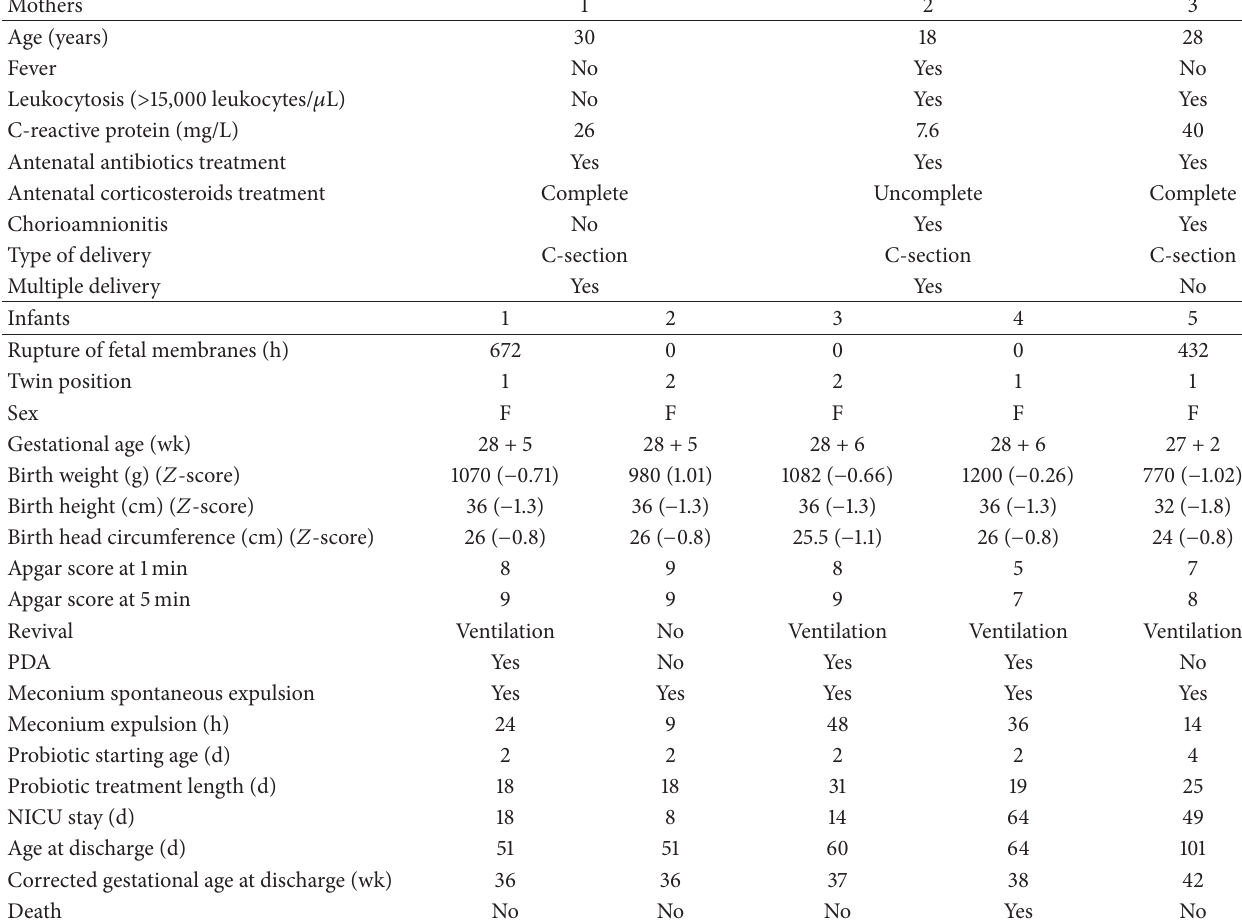
Table 1: Epidemiological and clinical relevant data from the mother-infant pairs of this